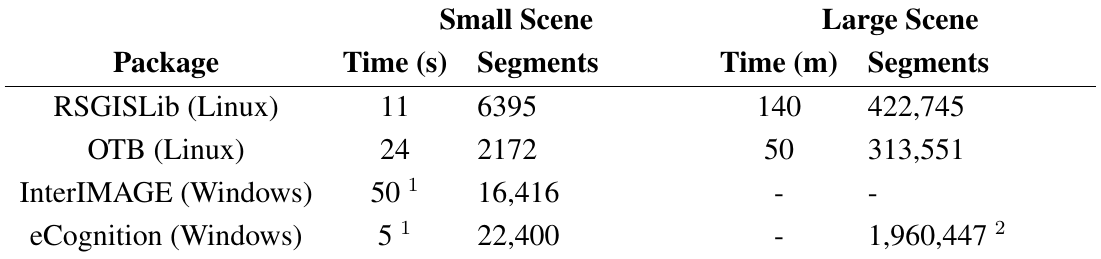
Table 3. A comparison of segmentation performance for four different GEOBIA packages using a small section of NIR aerial photography and a large mosaic of two Landsat 8